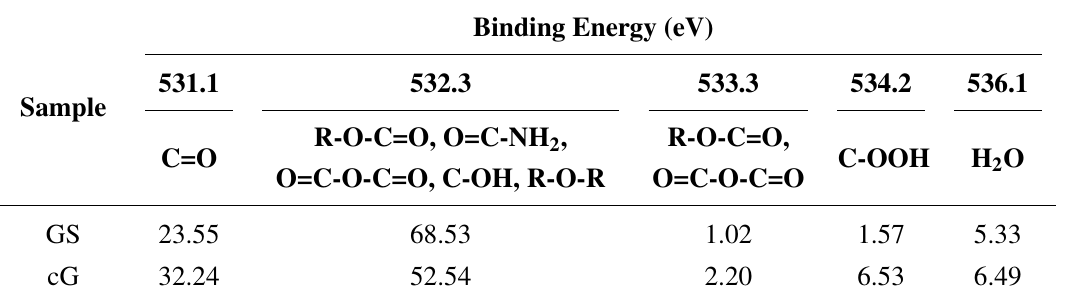
Table 2. Results of the fits of the XPS O1s region, values given in at.% of total intensity.